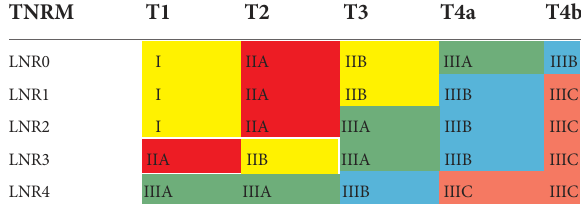
TABLE 5 TNRM staging system (suitable for LNs<12).